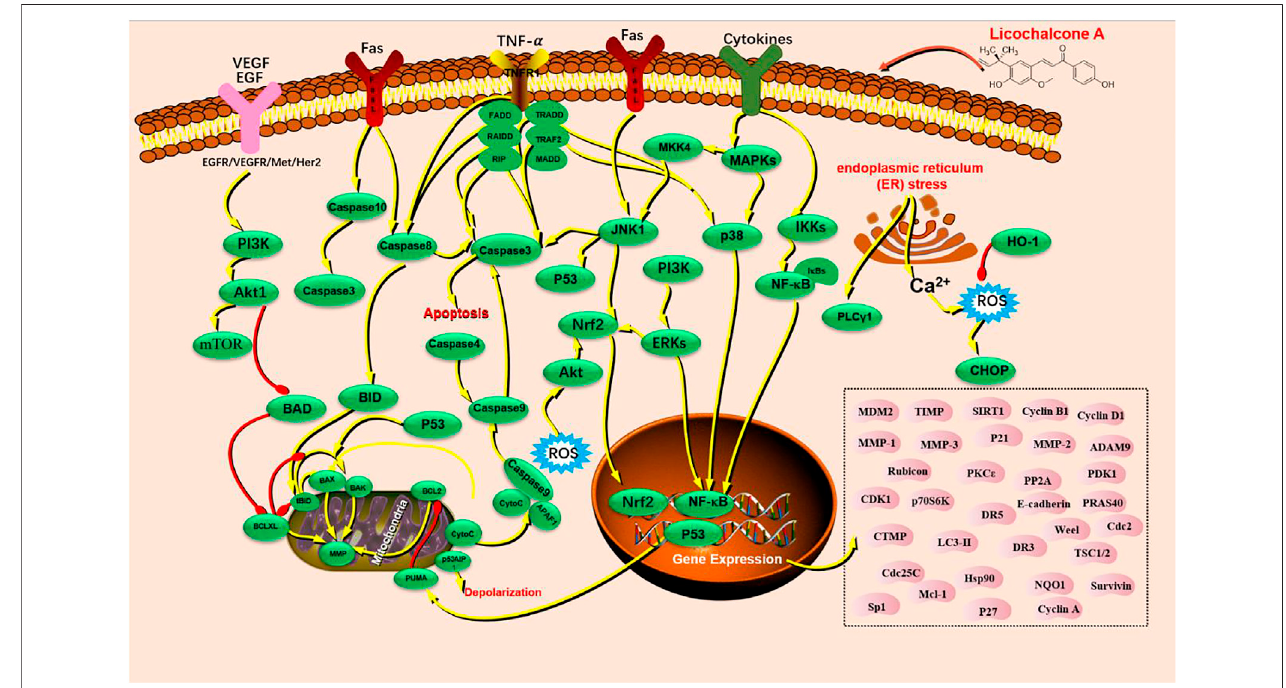
FIGURE 3 | The signaling pathways of licochalcone A with anticancer